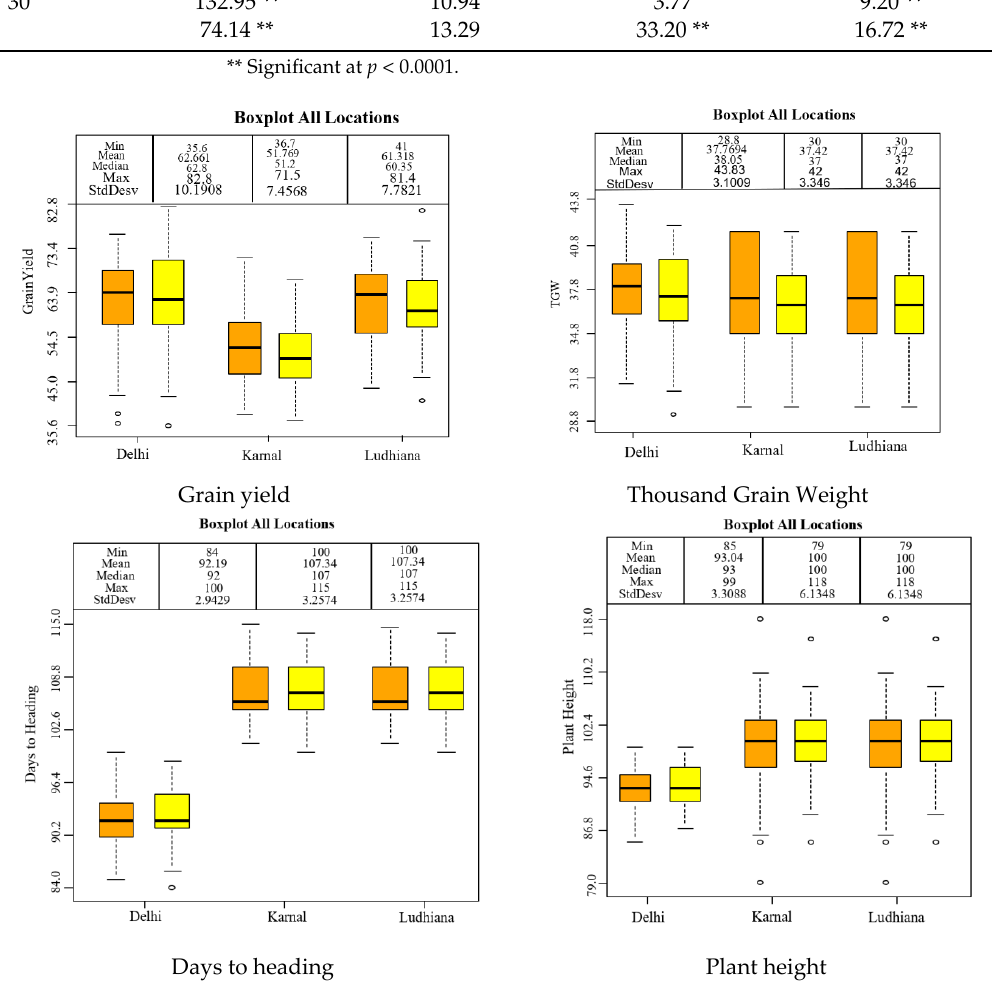
Figure 4. Box plot for grain yield and yield traits in early sown trial of 50 lines tested in three locations (Ludhiana, Karnal and New Delhi) of NWPZ of India in 2013 – 2014. The standard error bars are shown as dotted lines and circles as outliers. The horizontal bar in the box is the median or 50 th percentile.